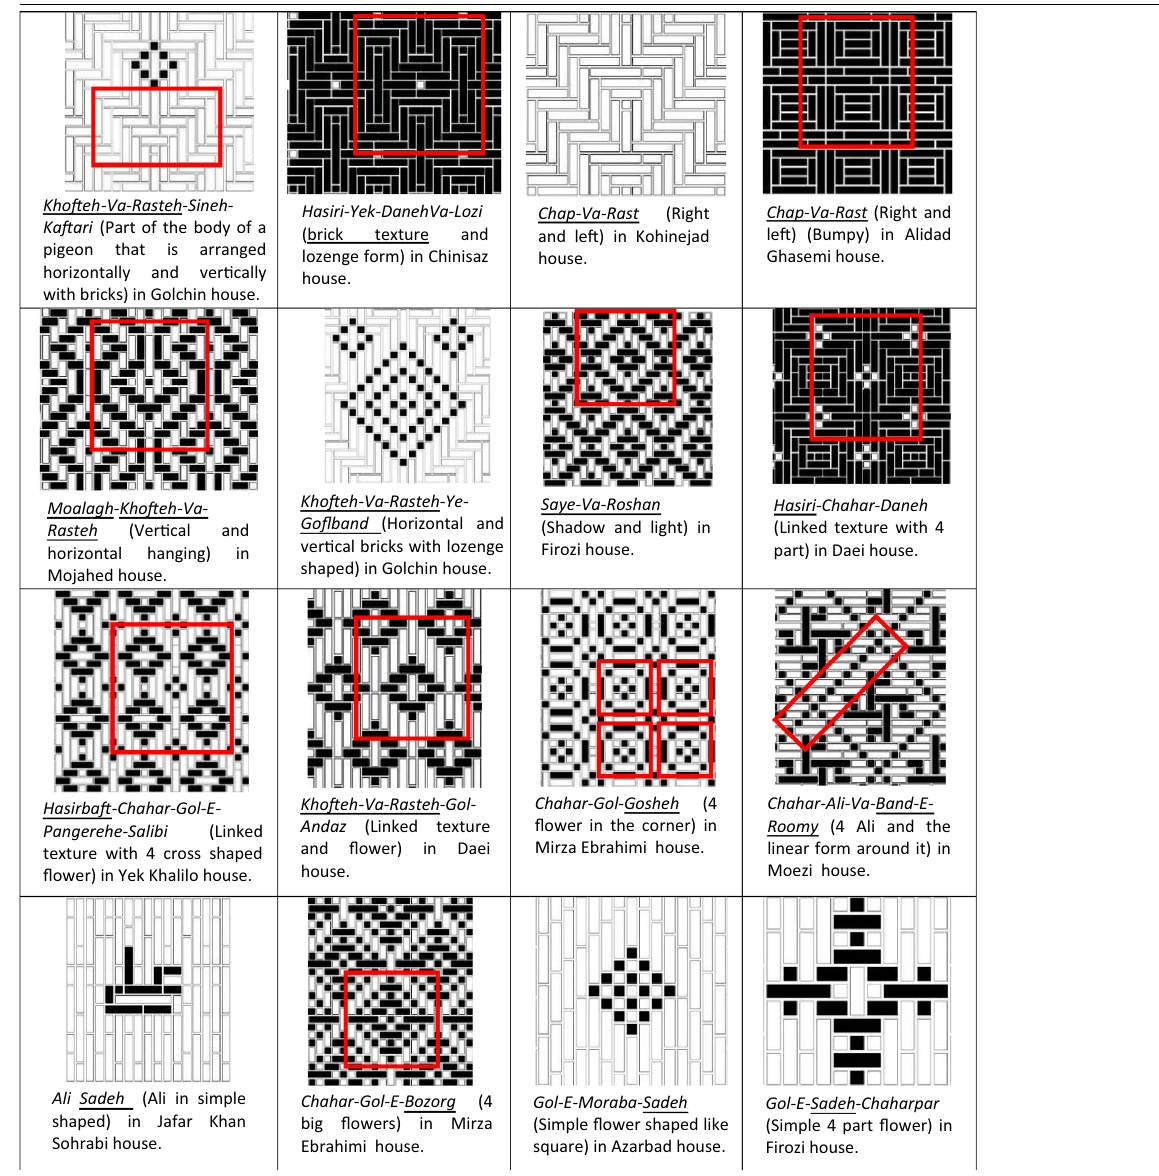
Table 6 The Xowun names in the motifs derived from the implementation and construction technique (the name of the brick decoration is derived from architectural terms in the native